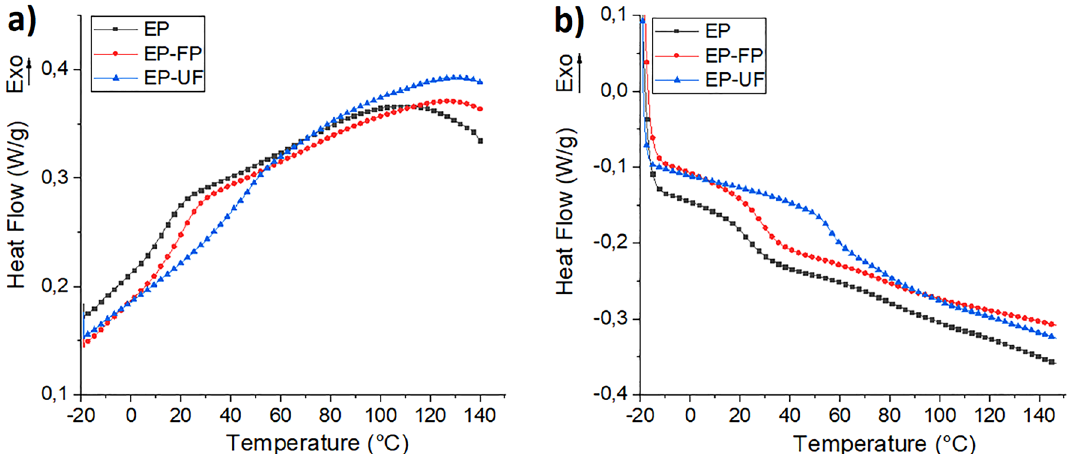
Figure 7. ( a ) Cooling and ( b ) Second Heating for neat EP and their fique biocomposites.